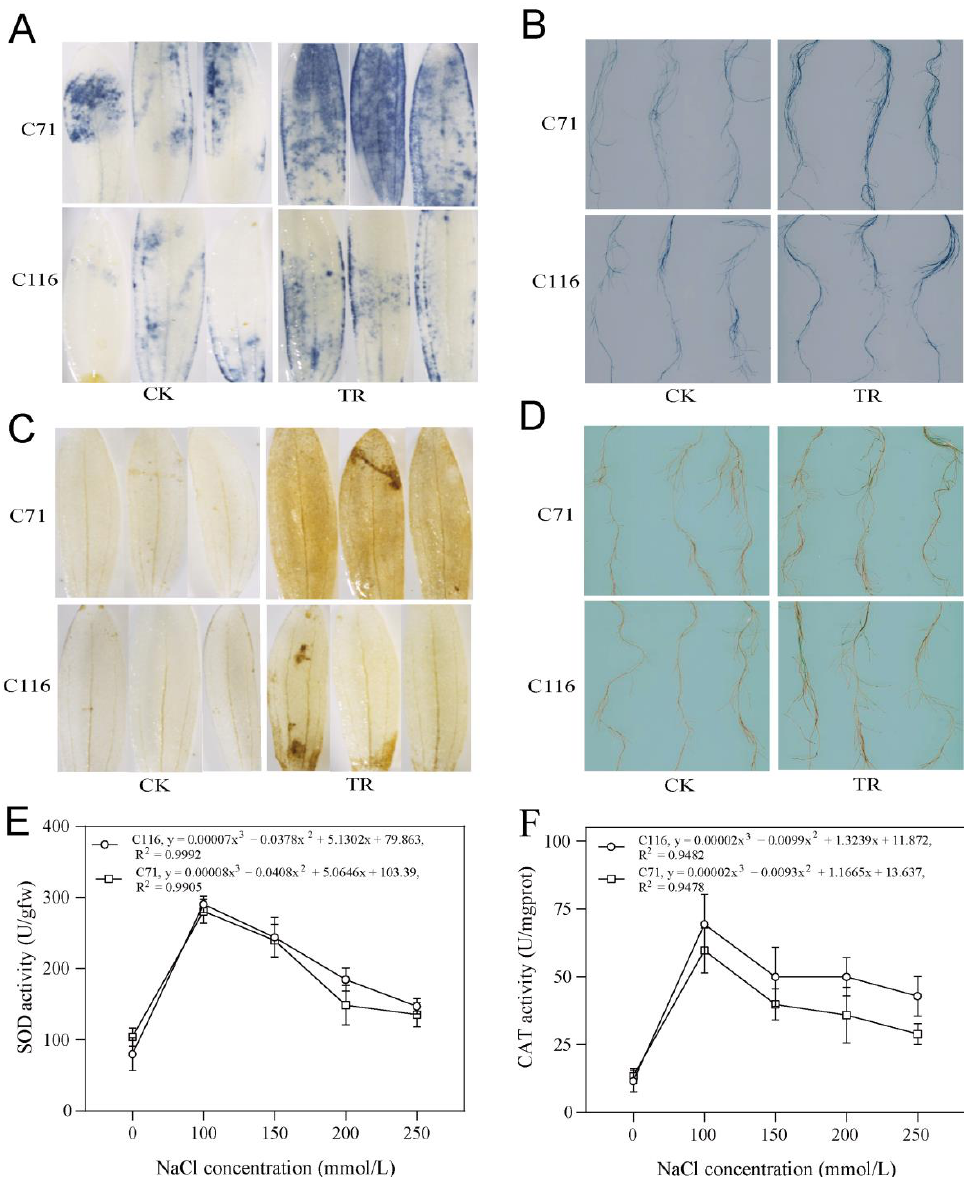
Figure 3. Antioxidant properties of resistant and sensitive materials under salt stress. ( A ) Flax leaves and ( B ) roots were chosen for NBT staining. ( C ) The cotyledons and ( D ) root systems of flax were used for DAB staining. CK, the control from 0 mmol/L NaCl; TR, the treatment from 200 mmol/L NaCl. ( E ) SOD enzyme activity assay and ( F ) CAT enzyme activity assay under different salt concentrations. In the curvilinear regression, y and x are the vertical and horizontal values, respectively, and R 2 represents the coefficient of